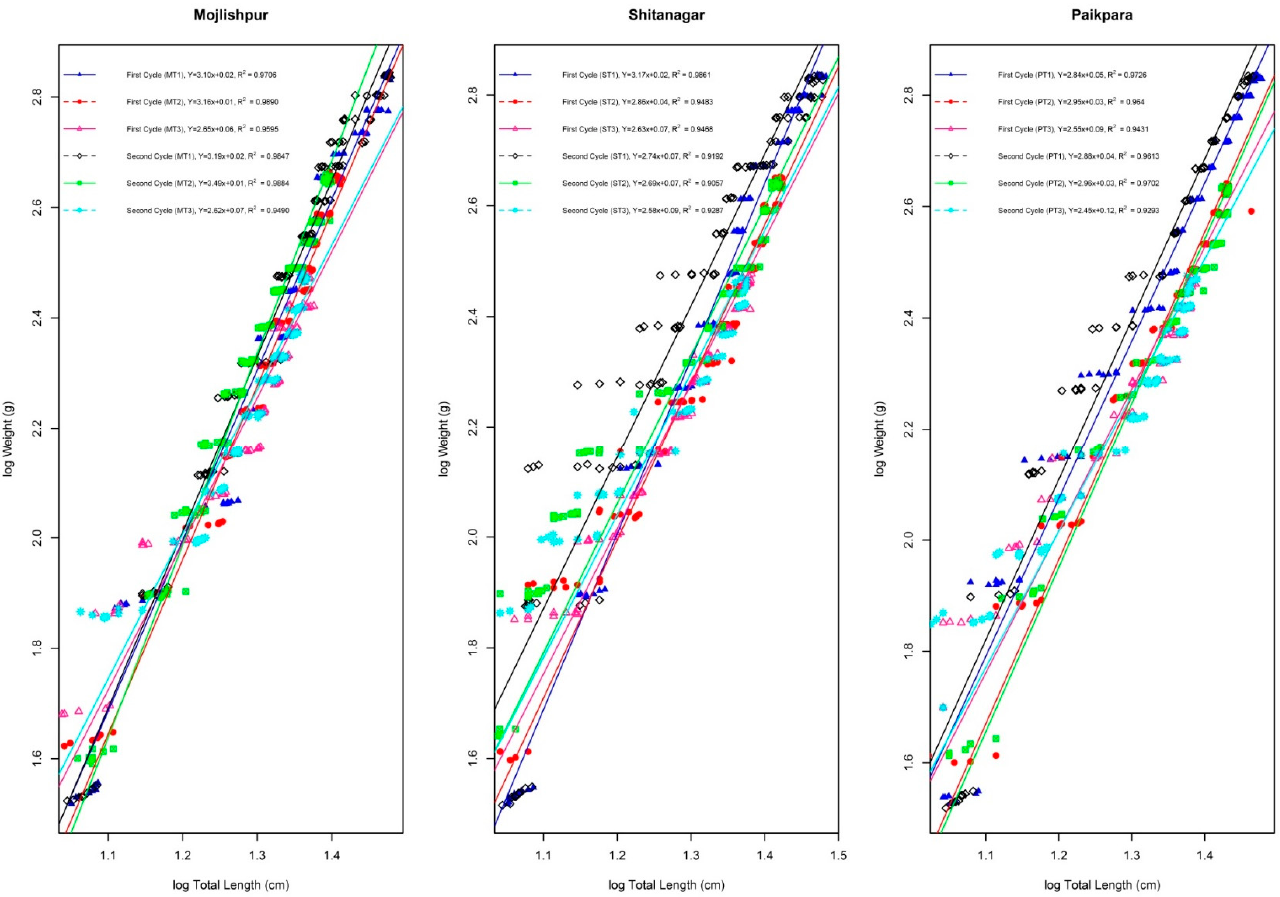
Figure 2. Linear regression analysis between data of various length–weight parameters of Nile Tilapia ( O. niloticus L.) from cages culture.